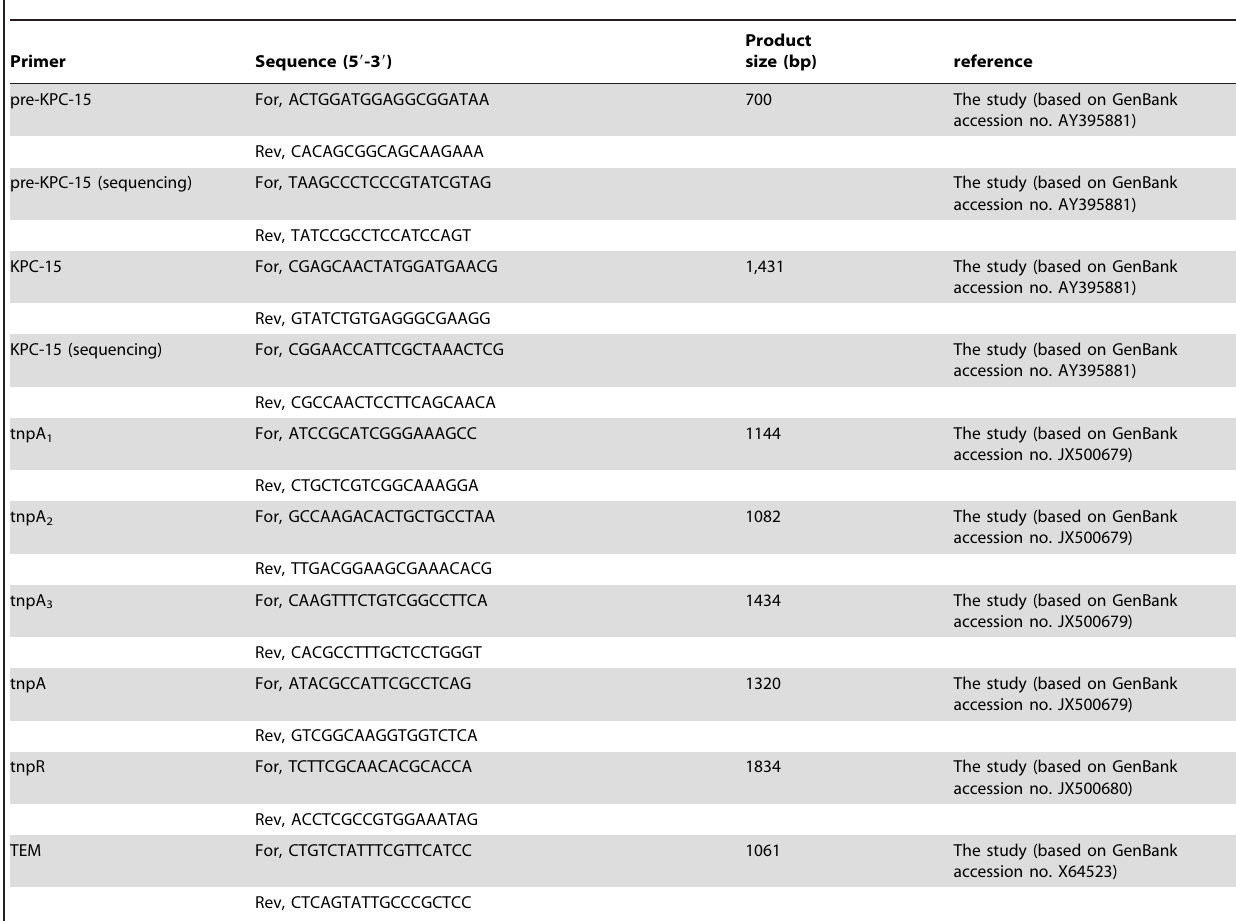
Table 1. Sequences of primers utilised to determine the bla KPC genetic environment in this